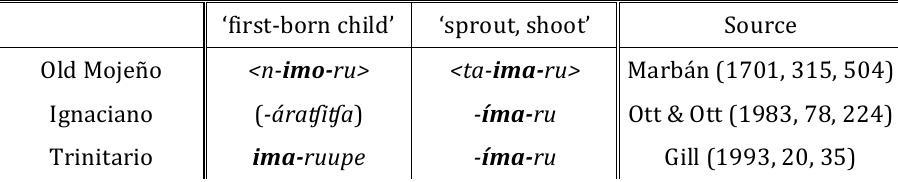
Table 6. Proto-Mojeño *-imV and supporting set of